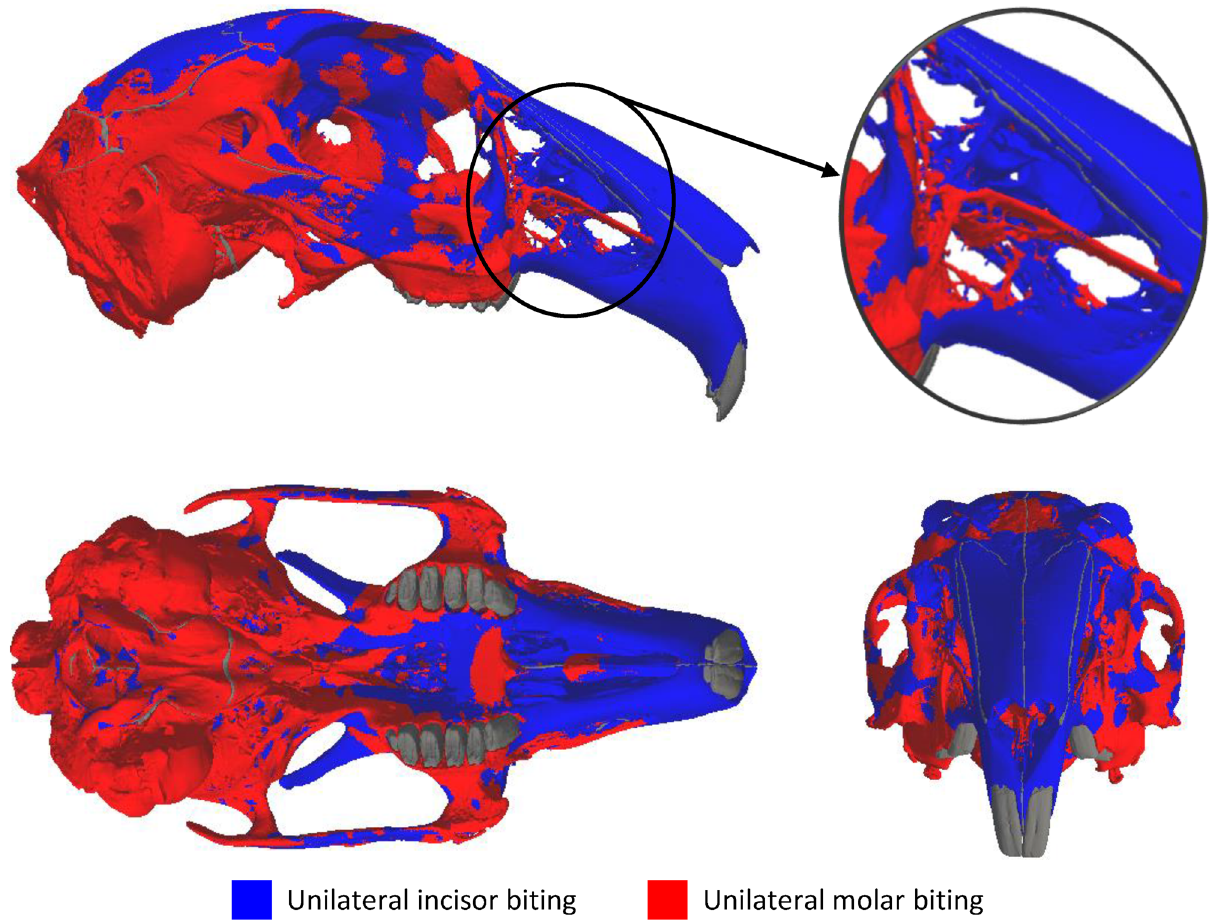
Figure 4. Dominant modes of biting over 12 separate unilateral bites (2 incisor and 10 molar bites). The plots show which mode of biting produced the largest strain in each element: blue represents regions where unilateral incisor biting produced the largest strains; red represents regions where unilateral molar biting produced the largest strains. The insert shows the rostrum. The teeth and sutures are shown in dark Figs. S3 and S4), therefore the peak strain distributions across the whole cranium (Supplementary Information Figs. S1 and S2) were observed to be similar to that of Fig. 2. Thus, the sensitivity of results to soft tissue elastic